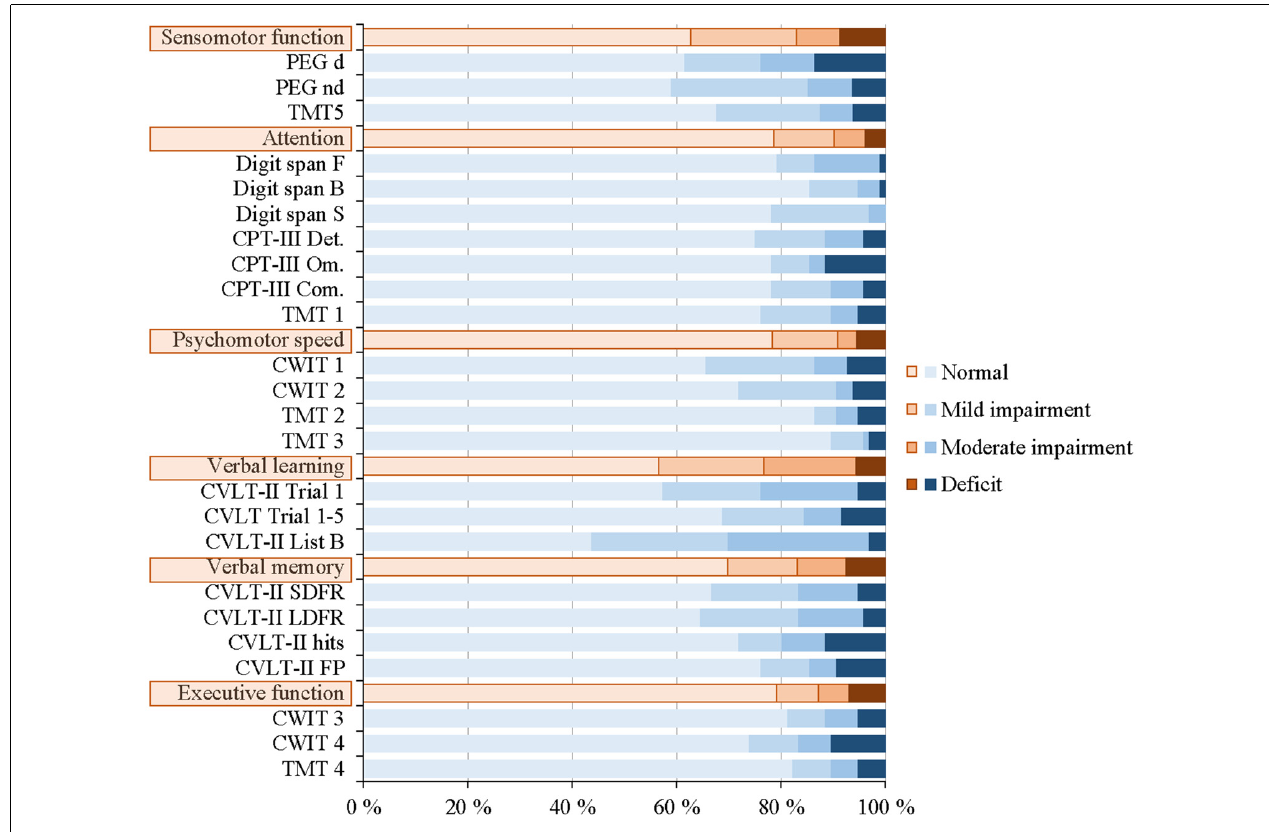
FIGURE 4 | Distribution of normal, mild and moderate impairment, and deficit for the individual neuropsychological tests and the six cognitive domains for all 96